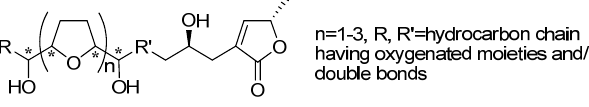
Figure 1. Representative structure of the Annonaceous